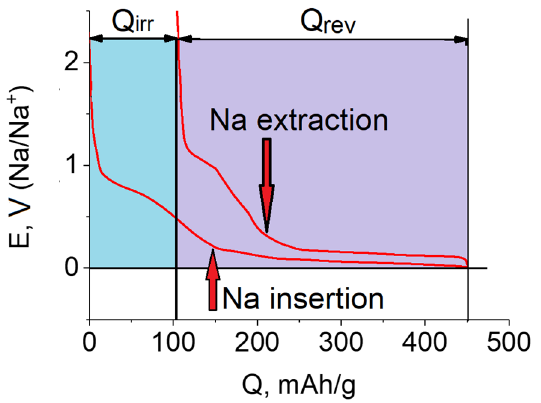
Figure 4. Galvanostatic charge (Na insertion) and discharge (Na extraction) curves of hard carbon electrodes and a scheme for determining reversible (Q rev ) and irreversible (Q irr ) capacity.